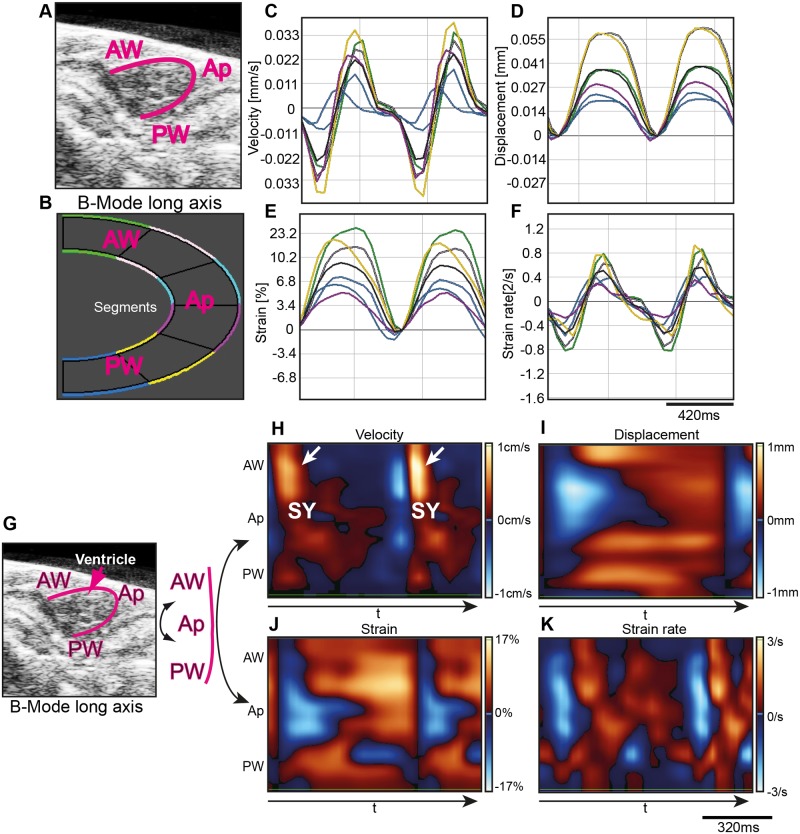
Advanced 2D wall motion in adult zebrafish hearts by speckle-tracking.(A) Representative LAX view with ventricular boundary outlined in pink. (B) Ventricle was divided into six color-coded segments as indicated with the green and light pink segment corresponding to the base of the anterior wall (AW), light blue and purple segments including the apex (Ap) and the dark blue and yellow segment corresponding the posterior wall (PW) base. (C-F) Representative segmental velocity traces (C), displacement traces (D), strain curves (E), and strain rate curves (F) for corresponding segments are shown. The black trace indicates the calculated average. (G) For high-resolution speckle-tracking representation the demarcated ventricular boundary was stretched as indicated with the top region representing the anterior wall (AW), the central region the Ap and the lower region the PW. (H-K) Absolute activity heat-maps of regional velocity (H), regional displacement (I), regional strain (J), and regional strain rate (K) of individual speckles during time (t) was plotted in a color coded fashion with high values shown in light red and low values in light blue as indicated. Notice that individual systoles (sy) and diastoles are distinguishable. White arrows in (H) indicate regions of high velocity in the AW in two distinct sy. Noticeably, AW activity is higher compared to the PW and Ap. Time scale bar as indicated. Ap, Apex; AW, anterior wall; PW, posterior wall; sy, systole.